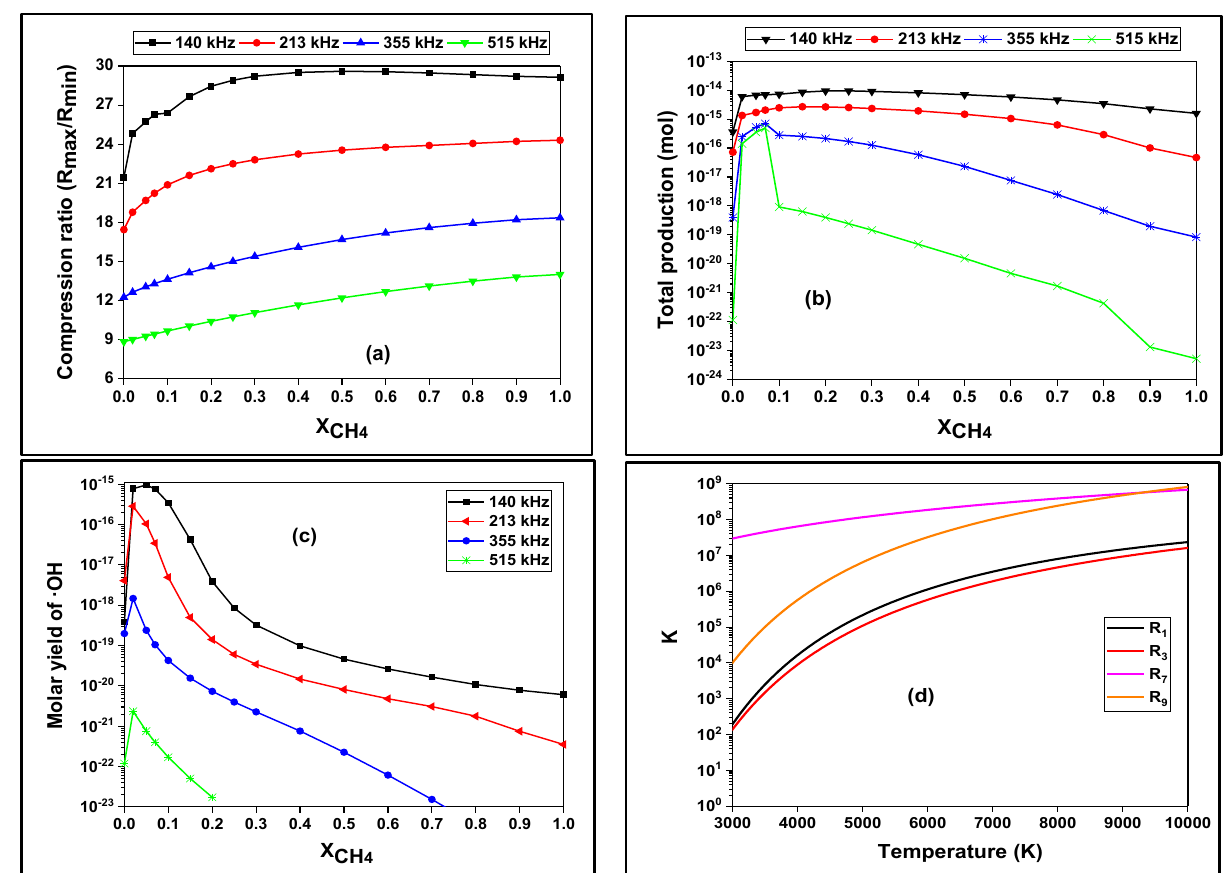
Figure 4. Impact of initial methane mole fraction and wave frequency (140 – 515 kHz) on: ( a ) com- pression ratio; ( b ) total bubble yield; and ( c ) molar production of • OH radicals. ( d ) Evolution vs. temperature of the rate constants of Reactions 1, 3, 7, and 9 of Table 3, units: m3 mol −1 s −1 (two-body reaction), m 6 mol −2 s −1 (three-body reaction).